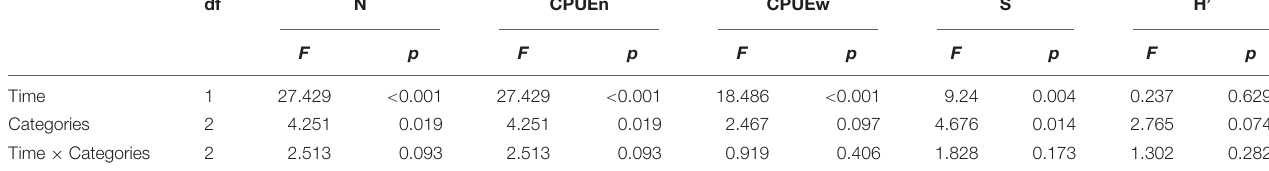
TABLE 1 | Summary of results of two-way ANOVAs employing numerical abundance (N), catch per unit effort (CPUEn = number of fish/m2/h and CPUEw = weight of fish/m2/h), richness (S) and Shannon’s index (H’) as response variables.